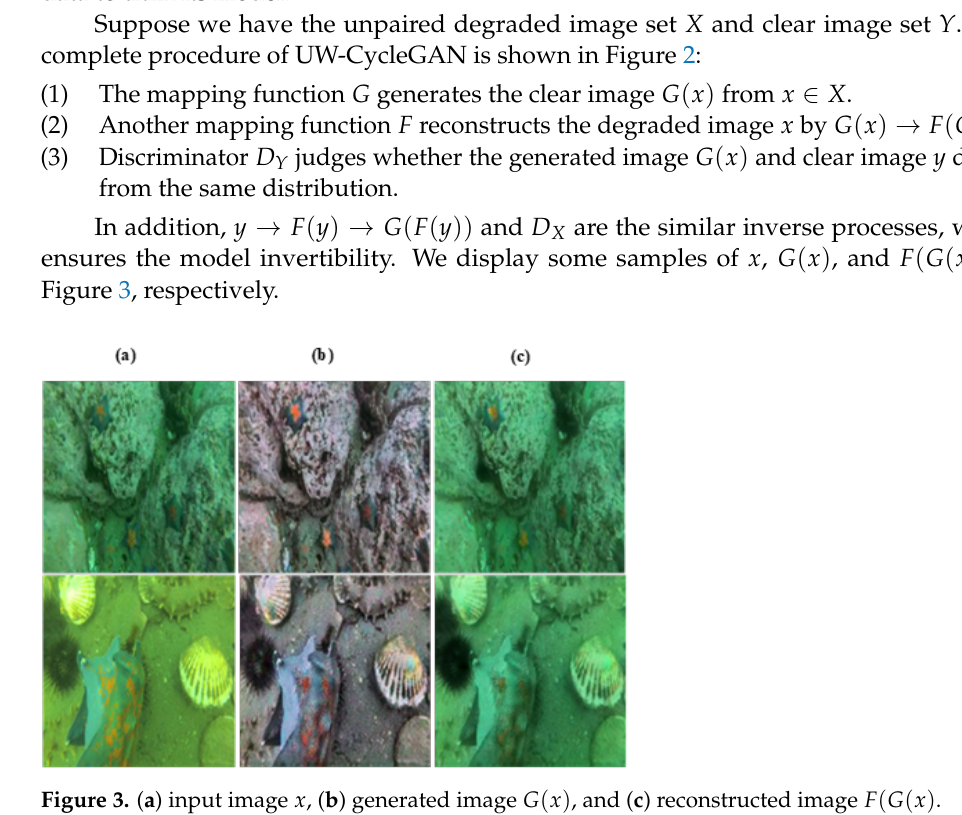
Figure 3. ( a ) input image x , ( b ) generated image G ( x ) , and ( c ) reconstructed image F ( G ( x )